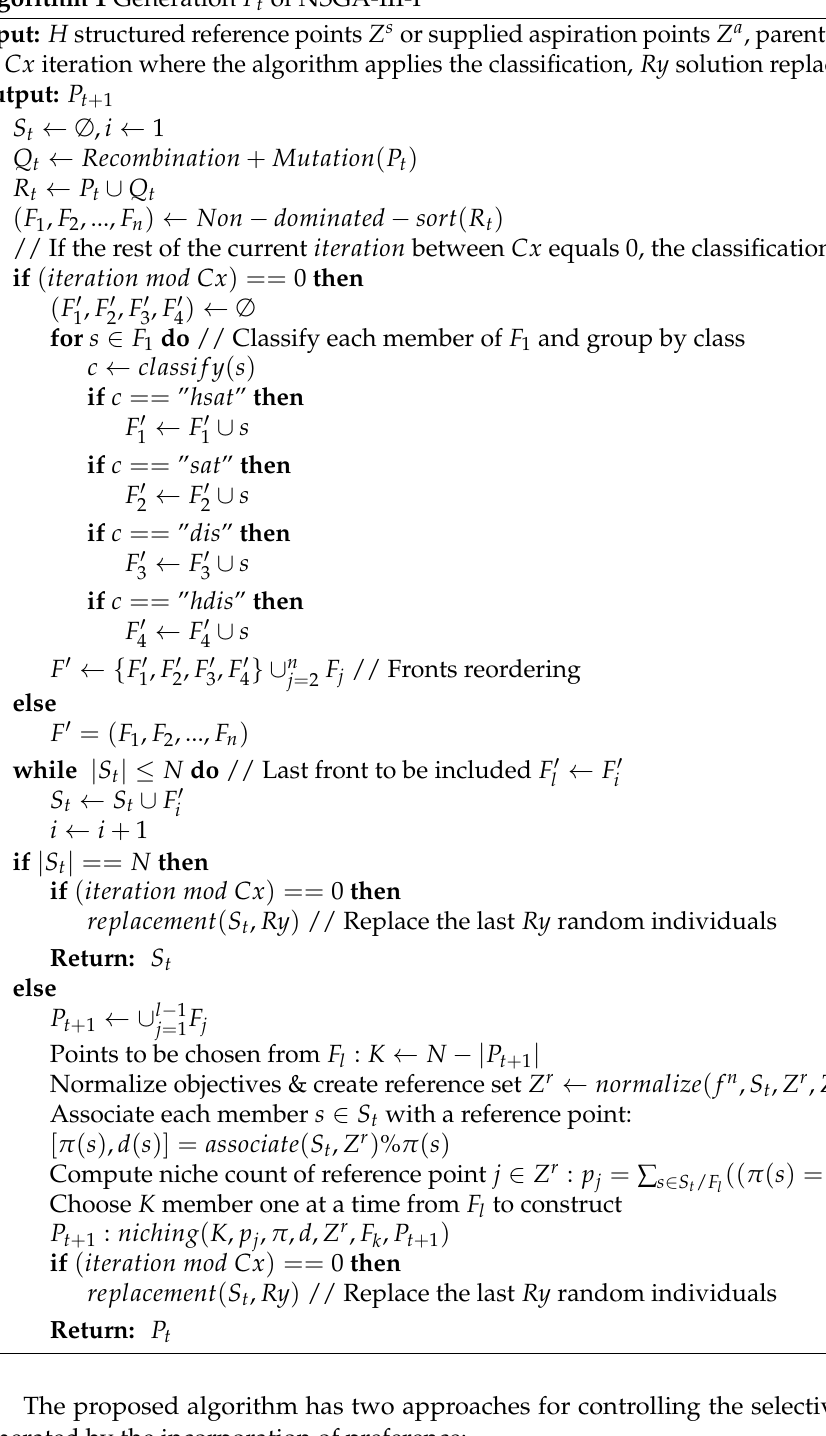
Algorithm 1 Generation P t of